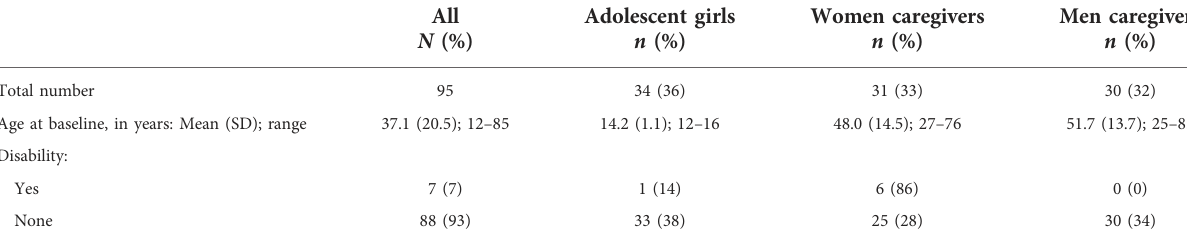
TABLE 2 Characteristics of quantitative study